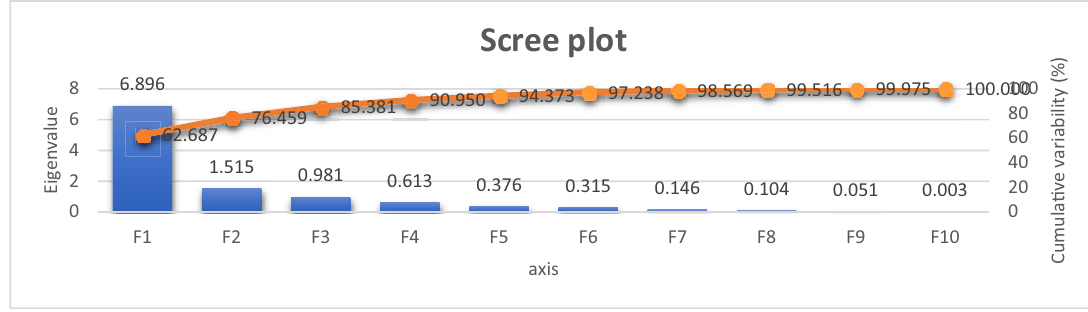
Figure 2: The eigenvalue of the selection criteria for the design auditing